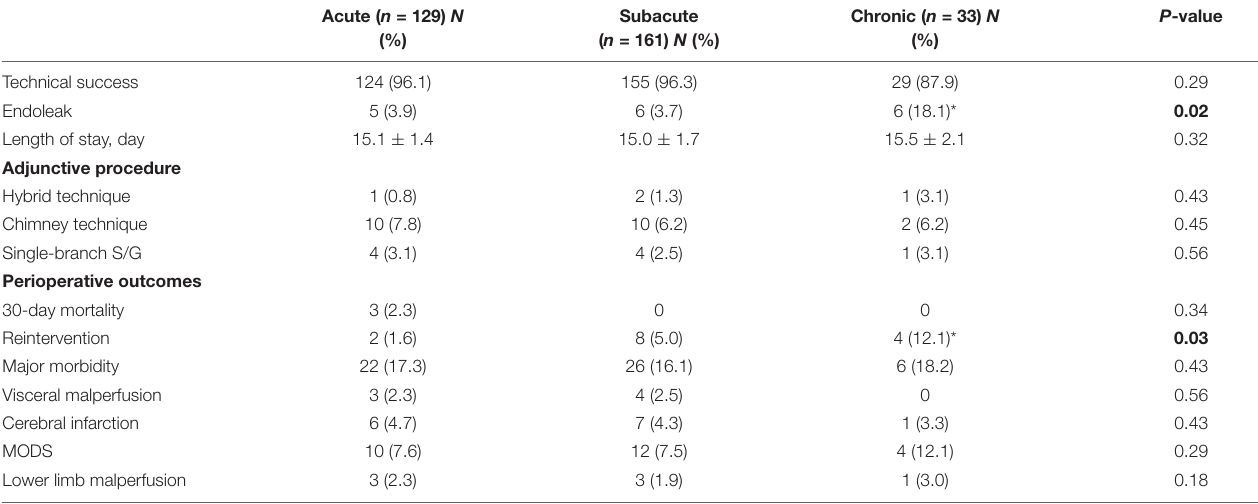
TABLE 2 | Procedure details and perioperative outcomes.